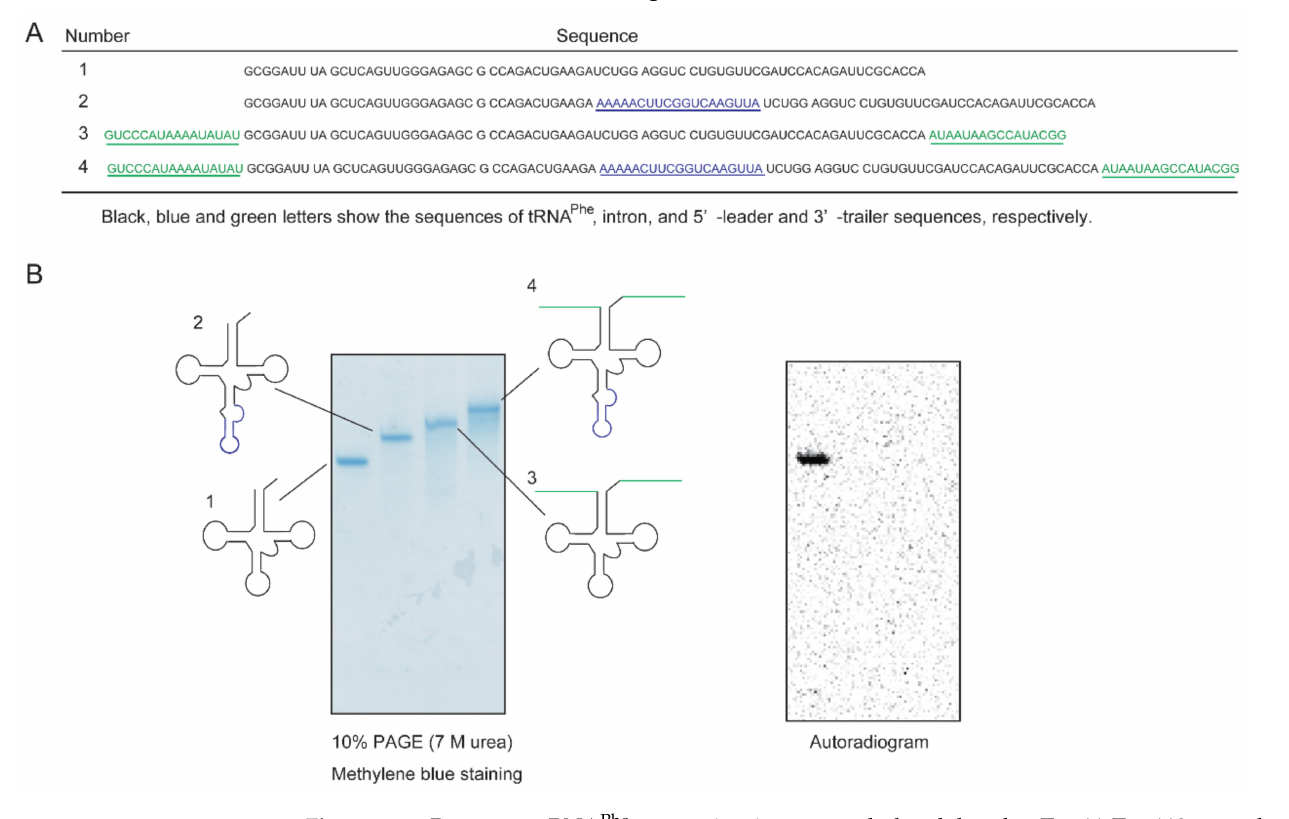
Figure 3. Precursor tRNA Phe transcript is not methylated by the Trm11-Trm112